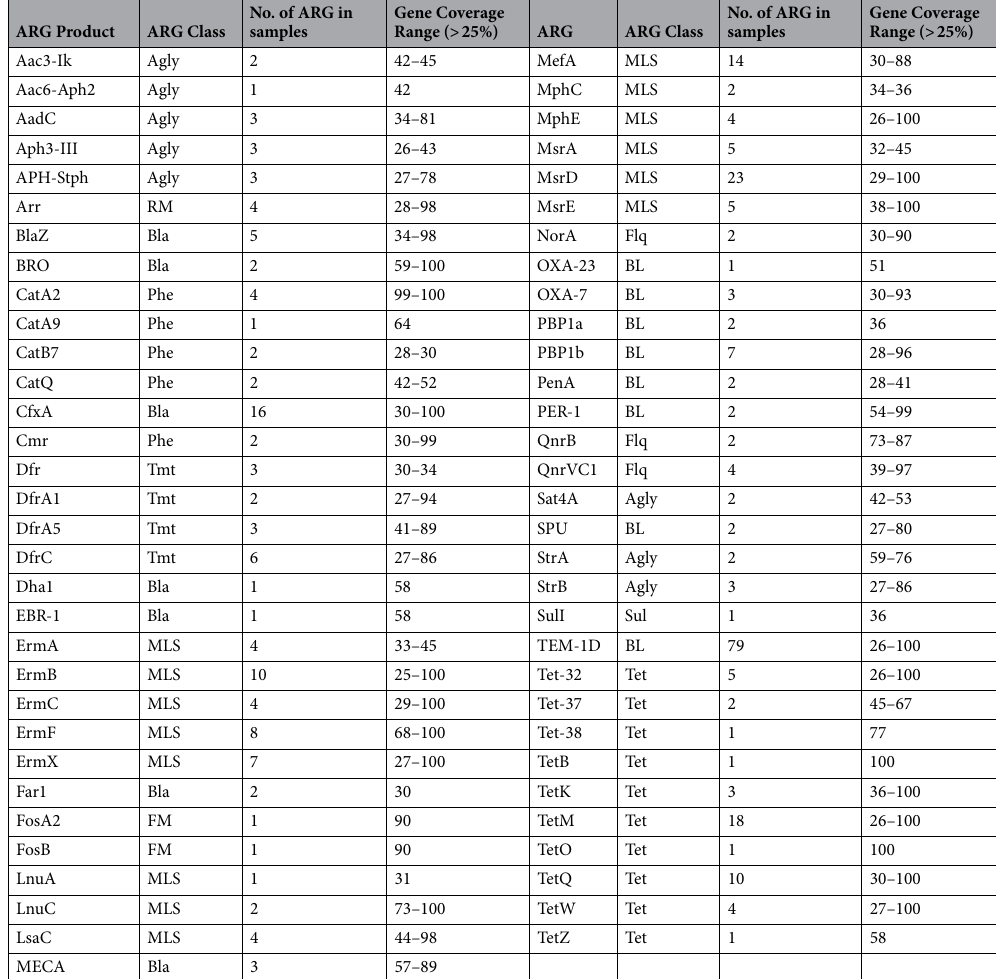
Table 3. ARG identified in nasopharyngeal mNGS data. Antimicrobial resistances encoded by ARG: Agly, aminoglycoside; Bla, β-lactam; Flq, fluoroquinolone; FM, fosfomycin; Phe, phenicol; Tet, tetracycline, RM, rifamycin; Tmt, trimethoprim; Sul, sulphonamide; MLS,